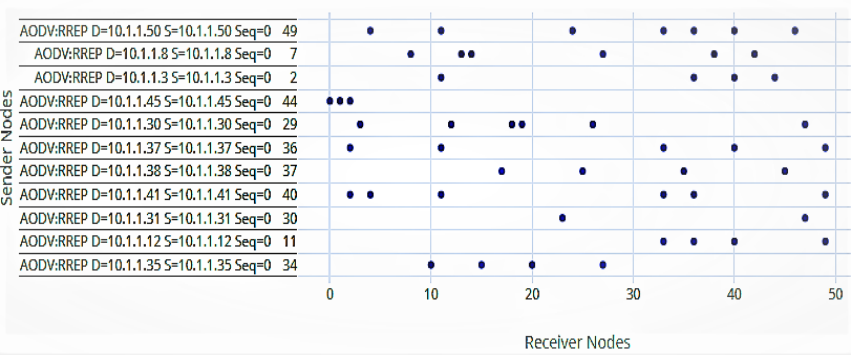
Figure 13. AODV Route